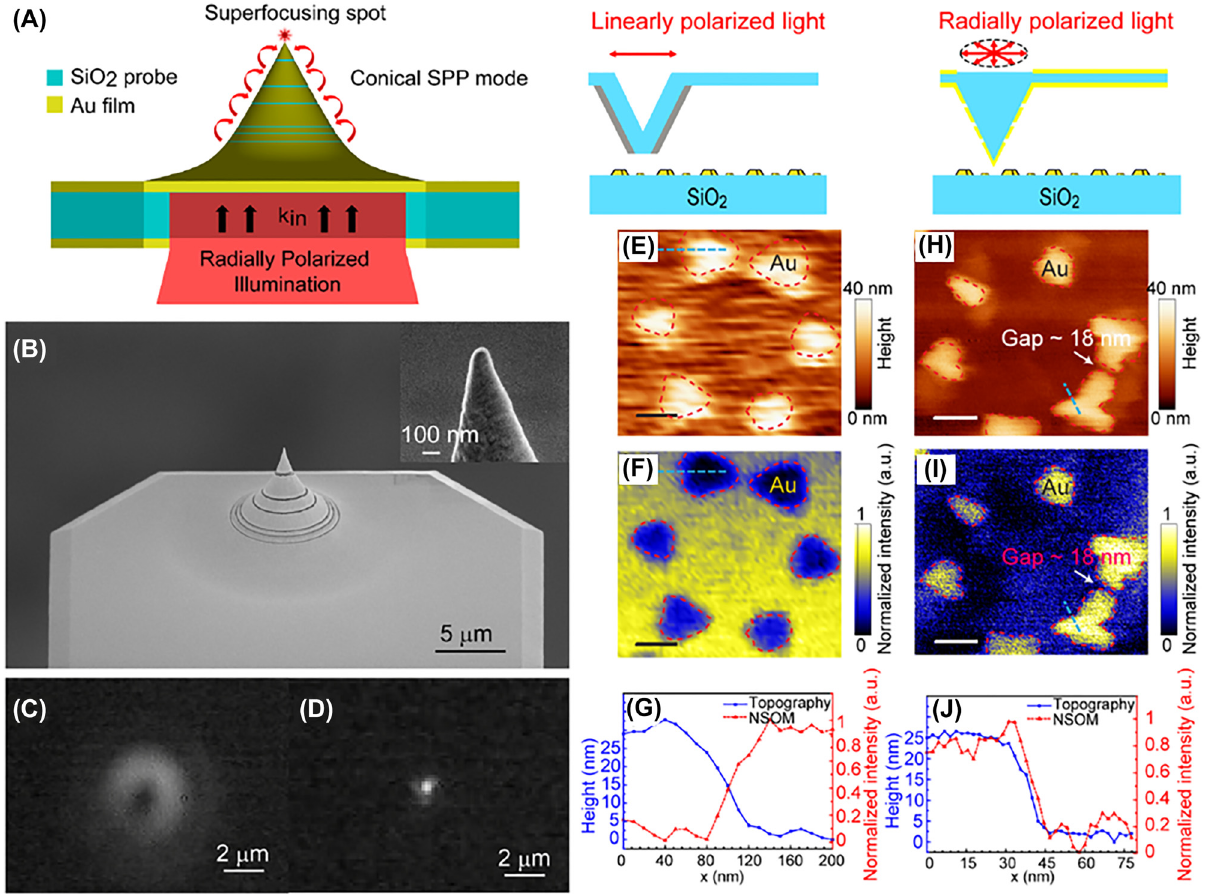
Figure 5: Scanning near field imaging illuminated via